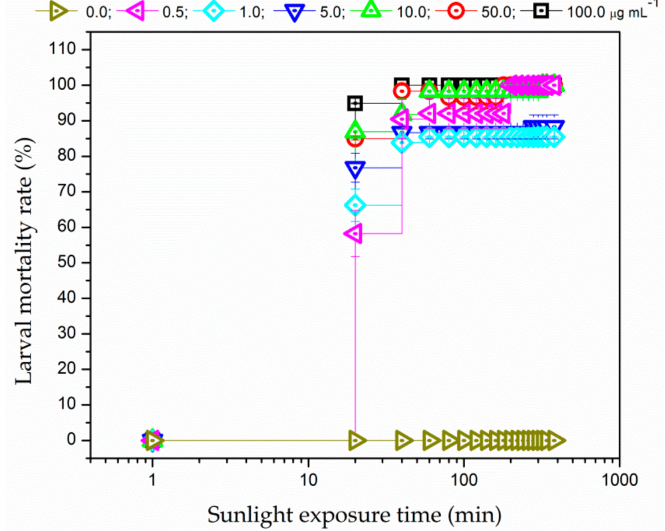
Figure 4. Larval mortality rate as a function of exposure time to solar irradiation of 135,000 lx for different EMB concentrations: ( δ ) 0.0, ( Ψ ) 0.5, (N) 1.0, ( ∆ ) 5.0, (9) 10.0, (.) 50.0, and (#) 100.0 µ g mL − 1 . Error bars represent